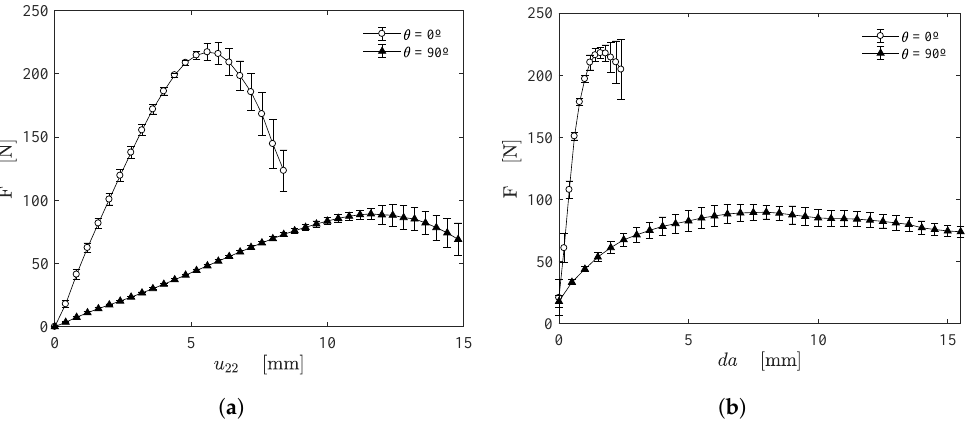
Figure 12. ( a ) Force as function of the cross-head displacement ( u 22 ) and ( b ) the crack growth ( da